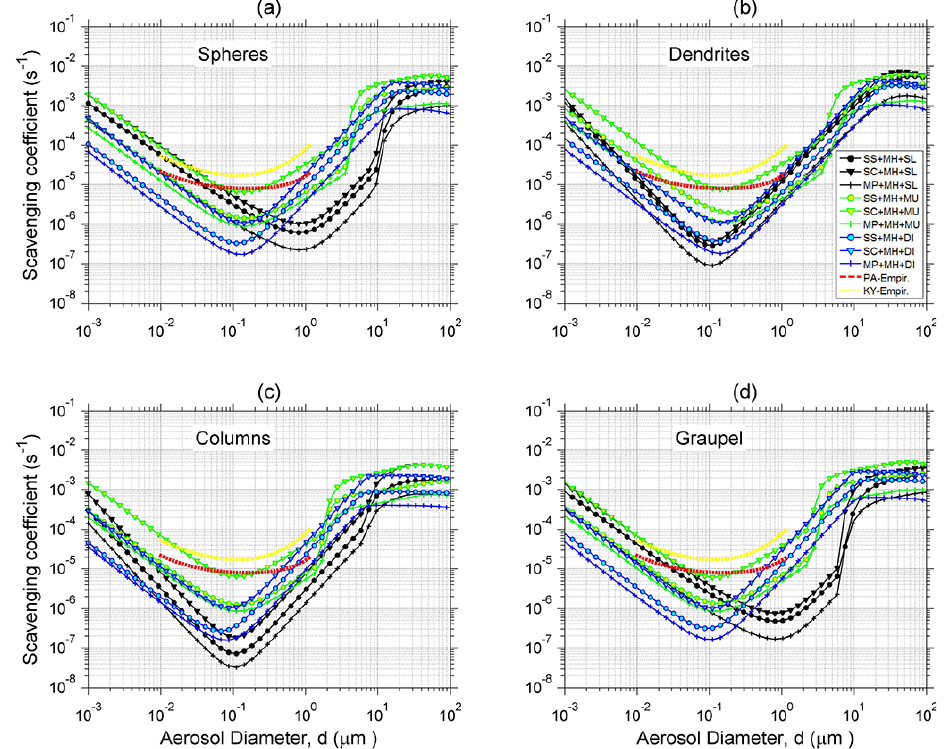
Fig. 8. Same as in Fig. 7 but for a snowfall intensity of 1.0mmh − 1 (note change in y axis range with respect to Fig.